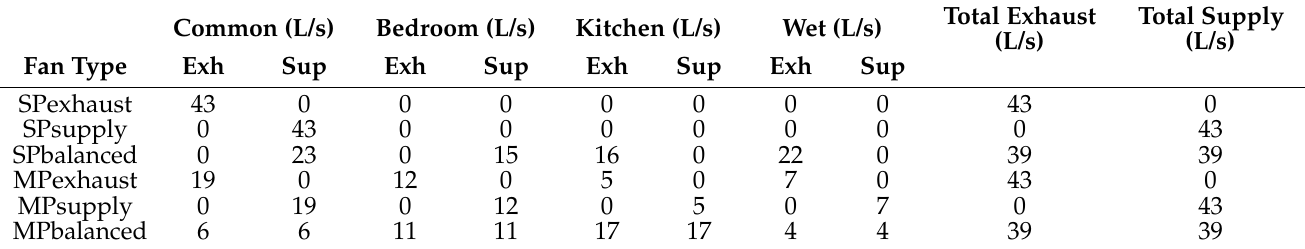
Table 2. Example zone ventilation fan flows for a one-story, one ACH 50 prototype dwelling in CZ1. Common